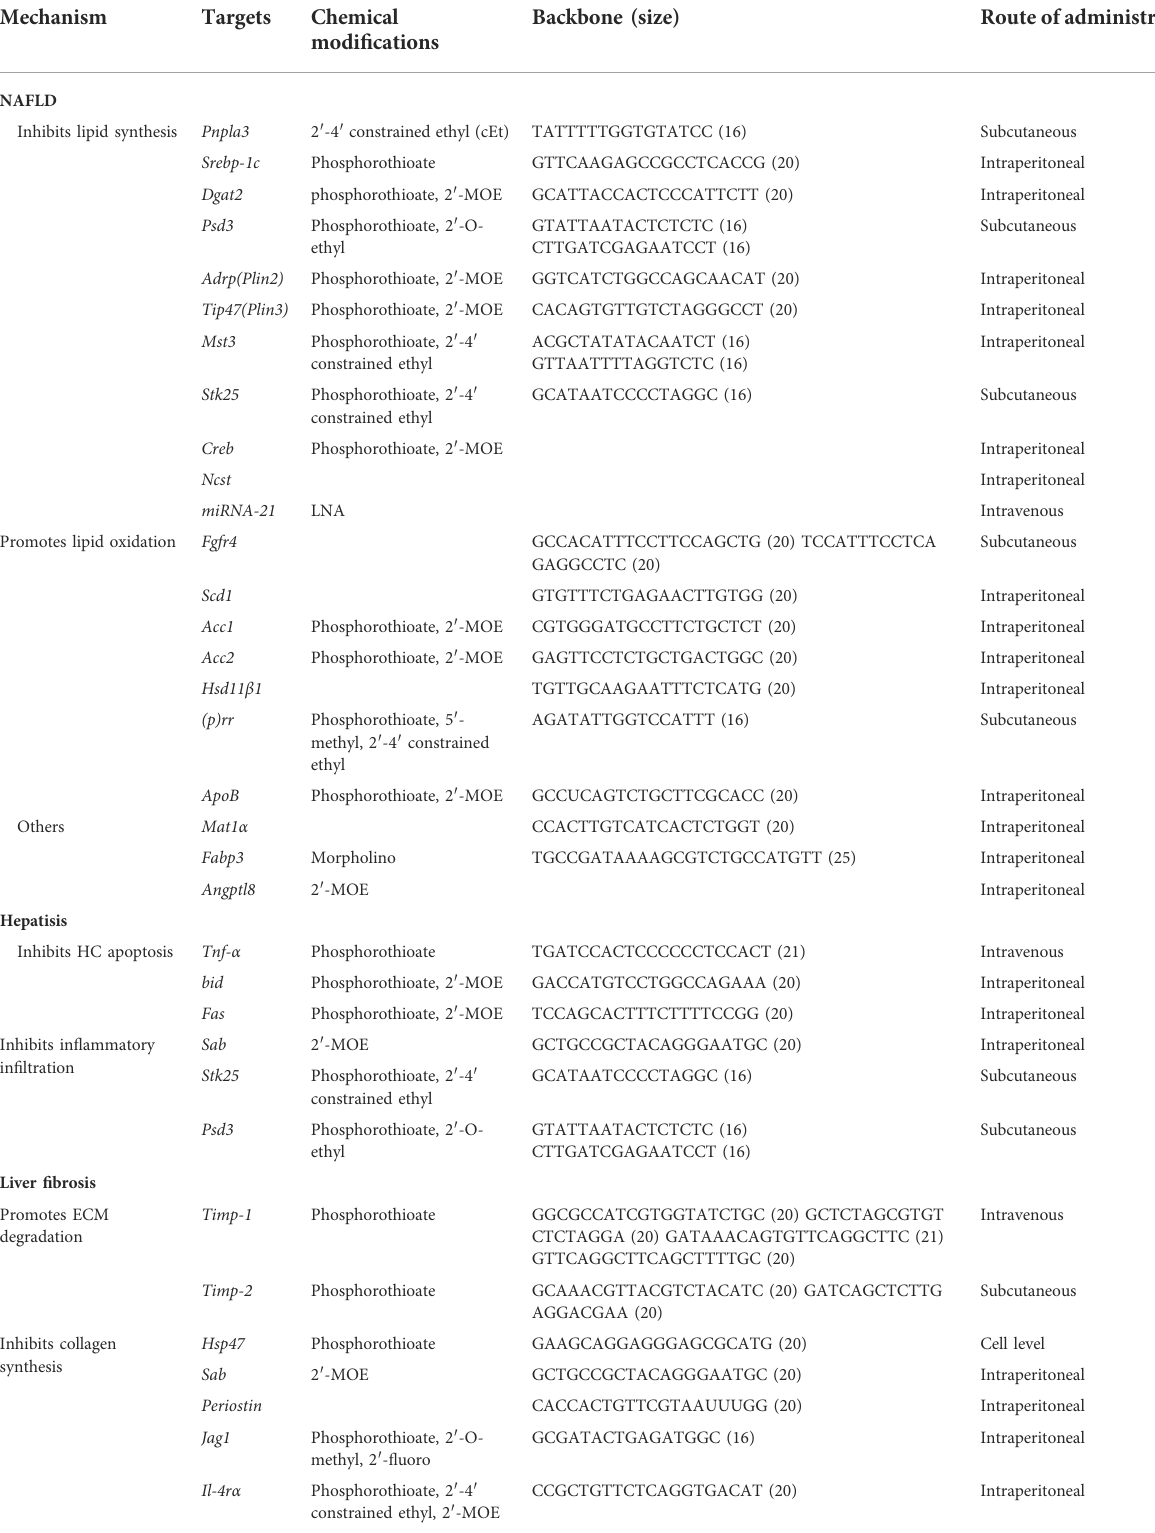
TABLE 2 A summary of studies on the application of ASOs in liver